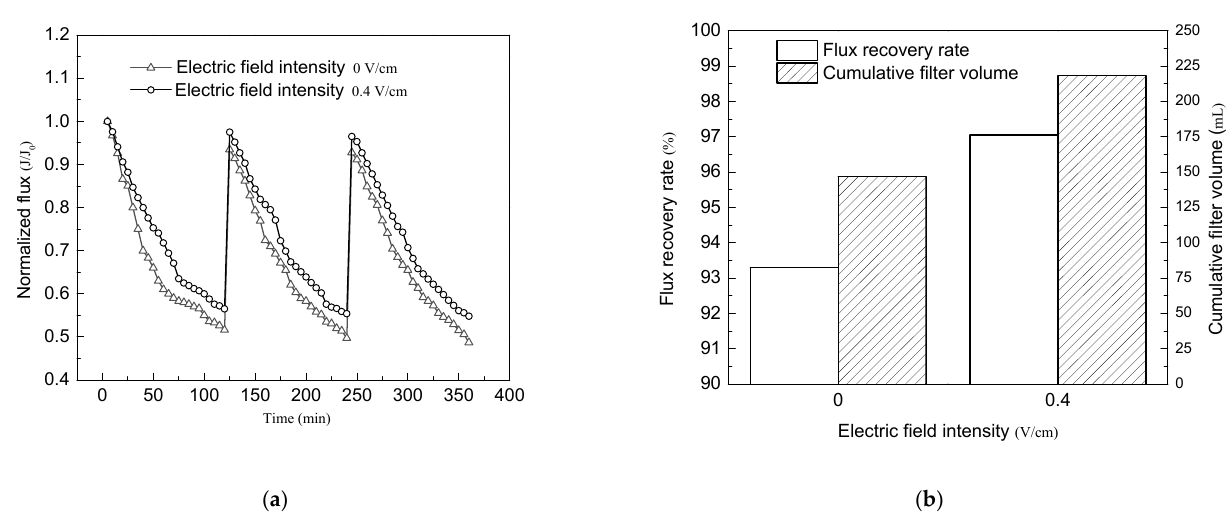
Figure 11. Filtration performance of MWCNTs/PVDF conductive membrane for yeast suspension: ( a ) Normalized flux varies with filtration time; ( b ) Flux recovery rate and cumulative filtered solution volume under different conditions.